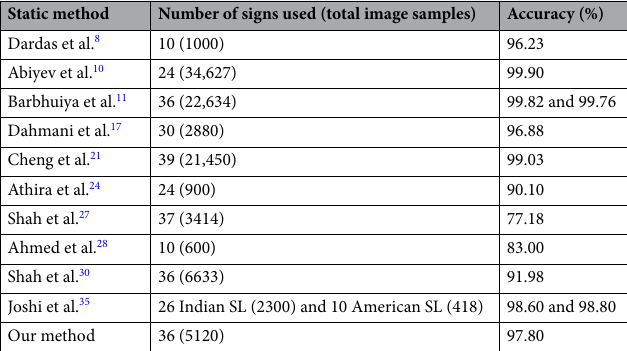
Table 7. Comparison with other static SL methods.